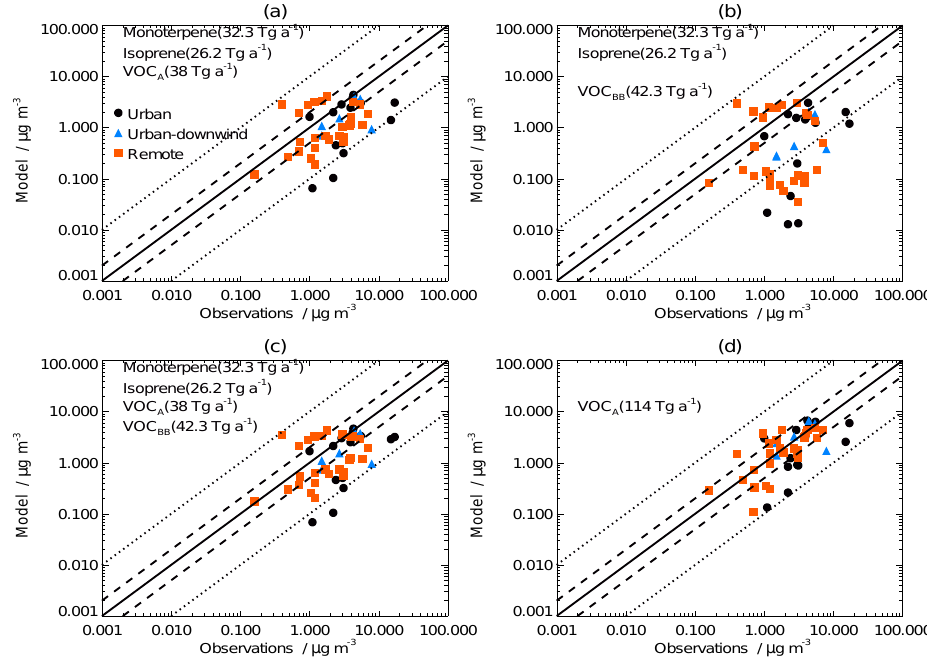
Fig. 4. As for Fig. 3. but for (a) simulation 11: monoterpene (32.3Tg(SOA)a − 1 ) , isoprene (26.2Tg(SOA)a − 1 ) , anthropogenic VOC (38. Tg (SOA) a − 1 ) ; (b) simulation 6: monoterpene (32.3Tg(SOA)a − 1 ) , isoprene (26.2Tg(SOA)a − 1 ) , biomass burning VOC (42.3Tg(SOA)a − 1 ) ; (c) simulation 17: monoterpene (32.3Tg(SOA)a − 1 ) , isoprene (26.2Tg(SOA)a − 1 ) , anthropogenic VOC (38.Tg(SOA)a − 1 ) , biomass burning VOC (42.3Tg(SOA)a − 1 ) ; (d) simulation 15: anthropogenic VOC (114.Tg(SOA)a − 1 )